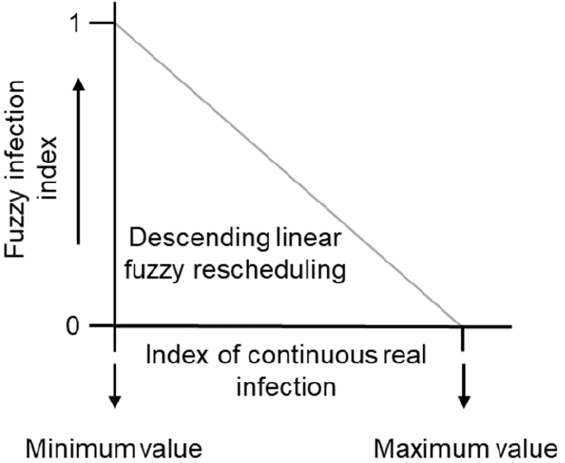
Figure 2. Fuzzy function for monolithically decreasing linear standardization of the infection index. With these data in hand, continuous maps of the risk index were prepared for each month and for the annual average in the state of Esp í rito Santo. Later, a single image representing the average risk index was generated, having as input data, the 12 monthly images of risk